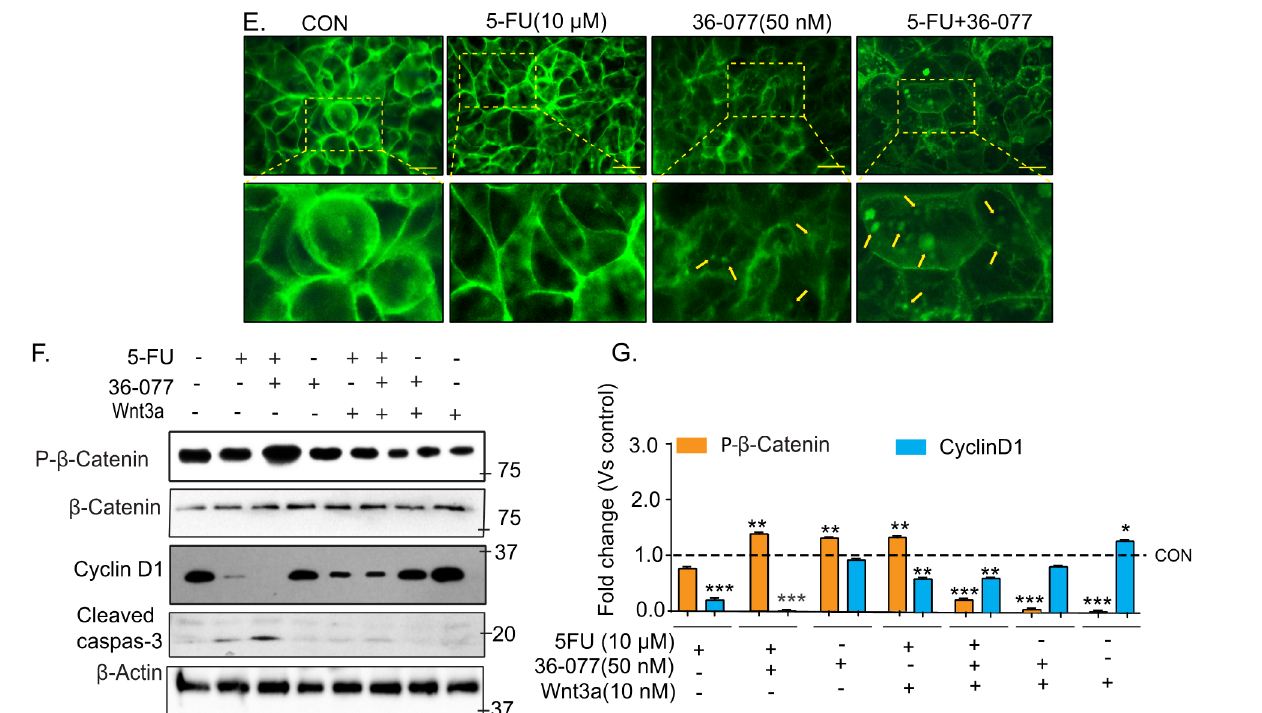
Figure 5. Combination therapy of 5-FU and 36-077 inhibits the WNT/ β -catenin signaling. Caco-2 cells transfected with TOP-FLASH reporter expression vector along with Renilla plasmid and beta-catenin promoter activity was analyzed by luciferase assay. ( A ) TOP-FLASH activity in Caco-2 cells treated with 5-FU, 36-077 or both. Transfection efficiency of cells was normalized with Renilla expression; ( B – D ) representative immunoblots for p - β -catenin (Ser33/Ser37/Thr41) and p -GSK3 β (Ser9) expression using the total cell lysates from Caco-2 cells, HCT116 cells, and colon tumoroids, respectively; ( E ) representative immunofluorescent analysis of β -catenin expression in Caco-2 cell treated with 5-FU with or without 36-077. Arrows indicate the aggregate formation and membrane localization; ( F , G ) immunoblotting and densitometry analysis of total cell lysate from Caco-2 cells treated with 5-FU+36-077 with and without WNT-3A, and densitometric analysis. Statistical significance was determined by 1-way ANOVA and Student’s t -test. *** p < 0.001, ** p < 0.01, * p < 0.05. Scale bar = 50 µ